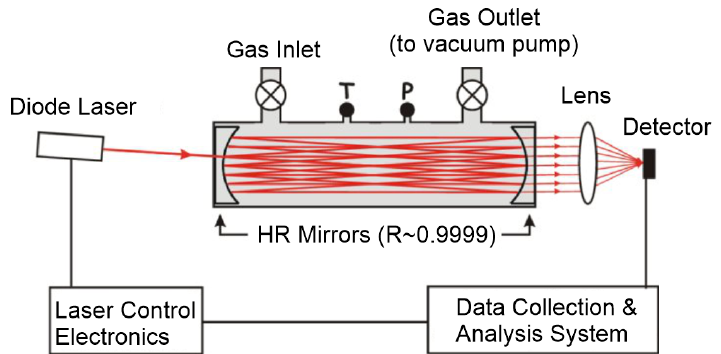
Figure 1. The schematic diagram of the off-axis Integrated Cavity Output Spectroscopy (ICOS) instrument.